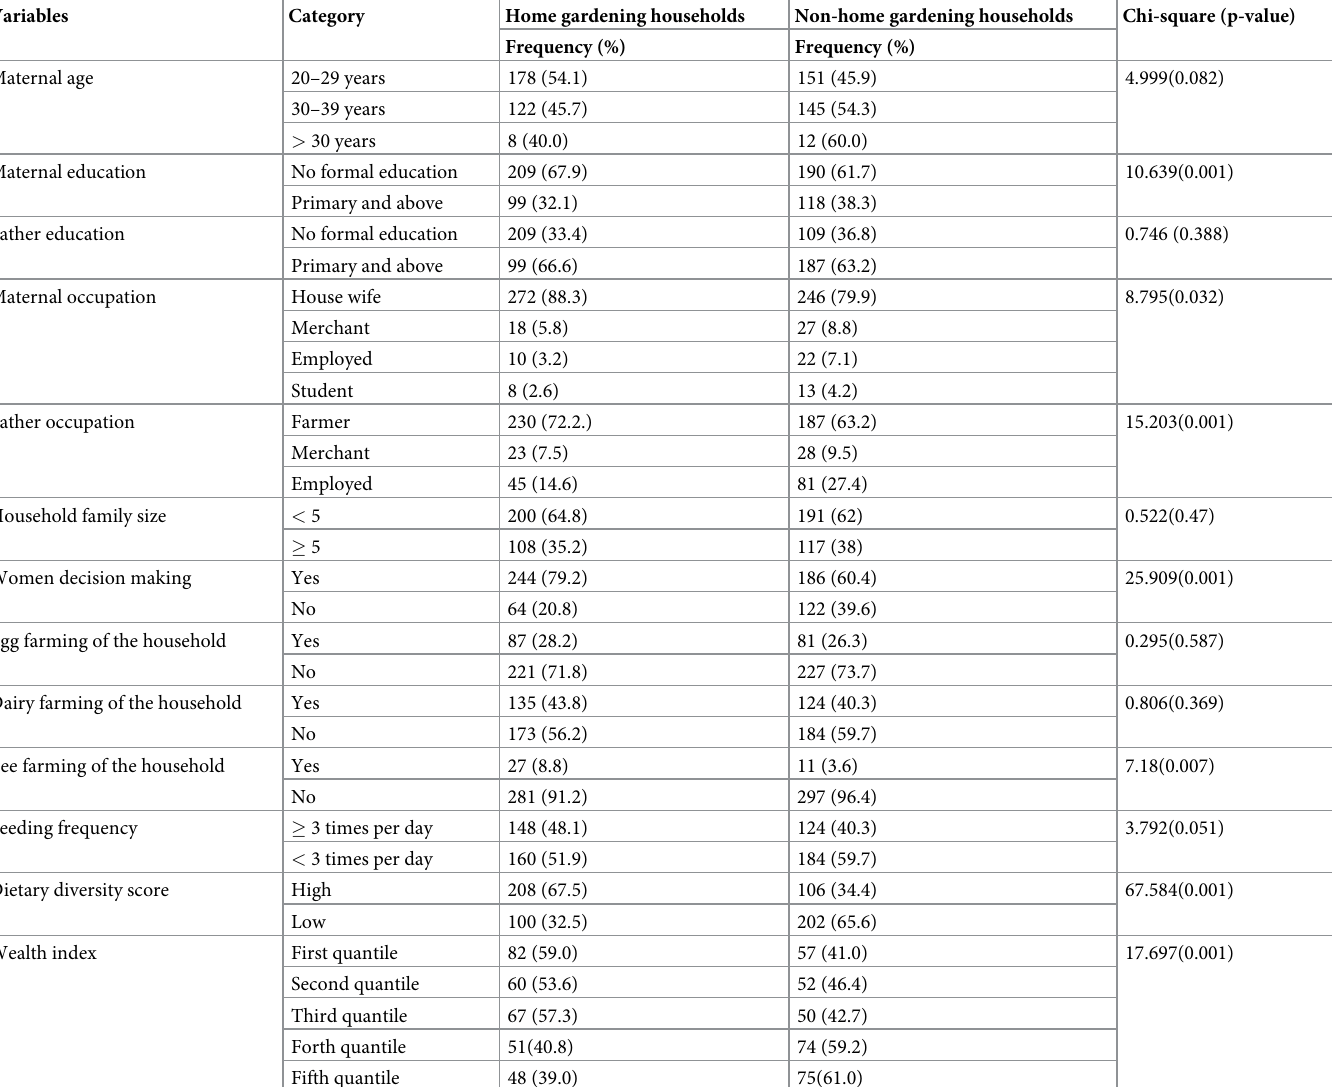
Table 1. Socio-demographic and economic characteristics of home gardening and non-home gardening households in Zegie, Northwest Ethiopia, 2019. Variables